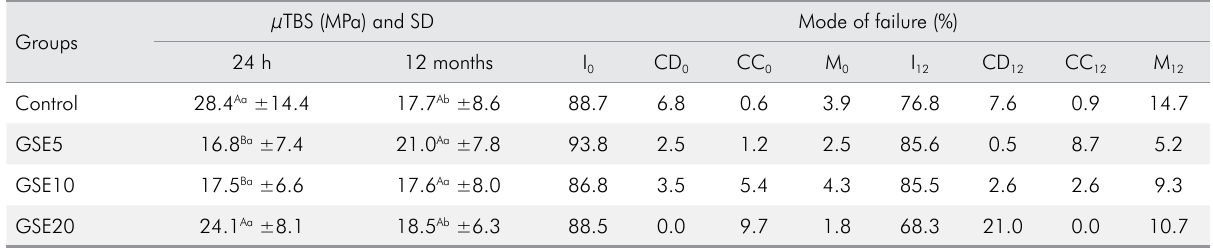
Table 2. Mean dentin microtensile bond strengths (µTBS) ± standard deviation (SD) and mode of failure (%). Groups